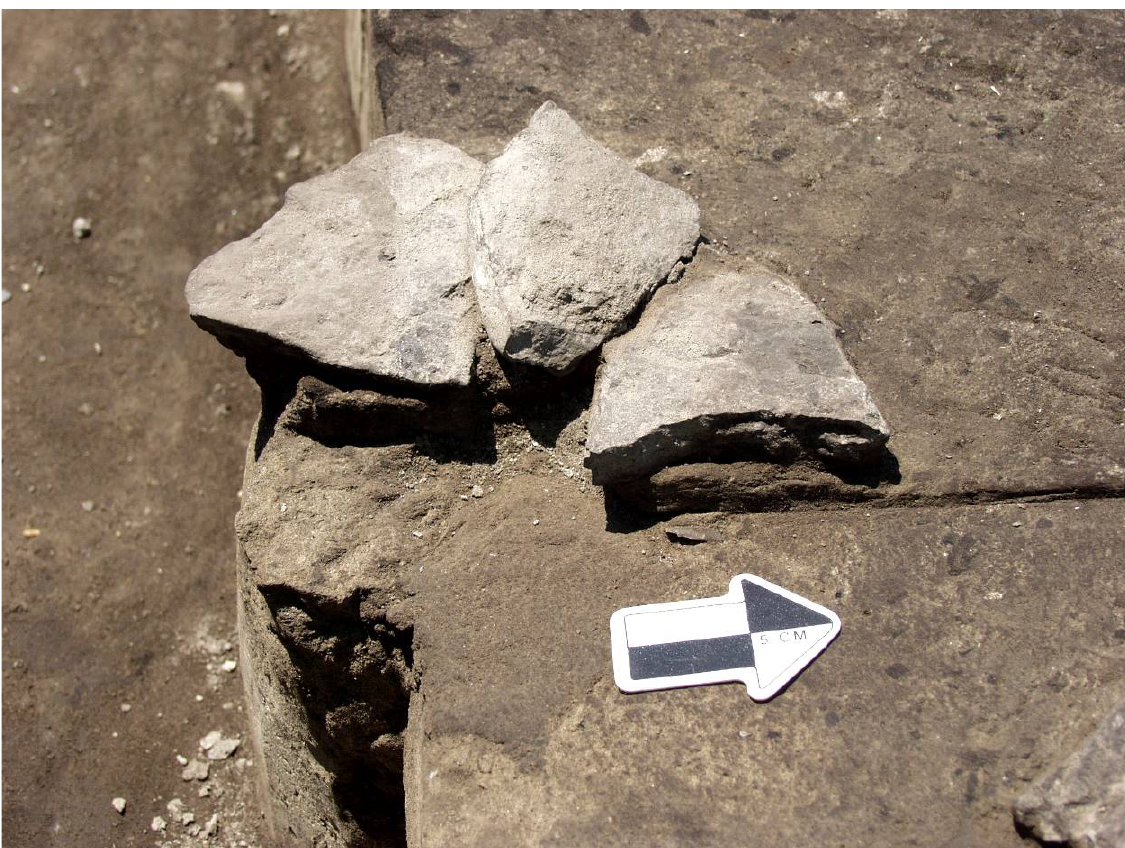
Figure 19. Flat thin basalt fragments, in situ as found. Scale arrow 5